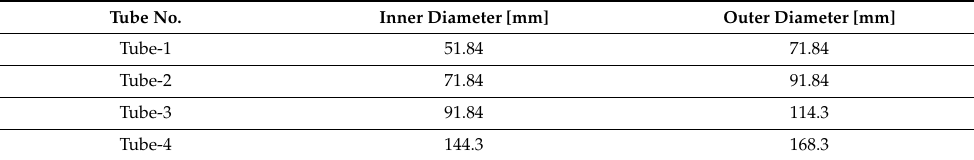
Table 2. Dimensions of the 4 tubes in test